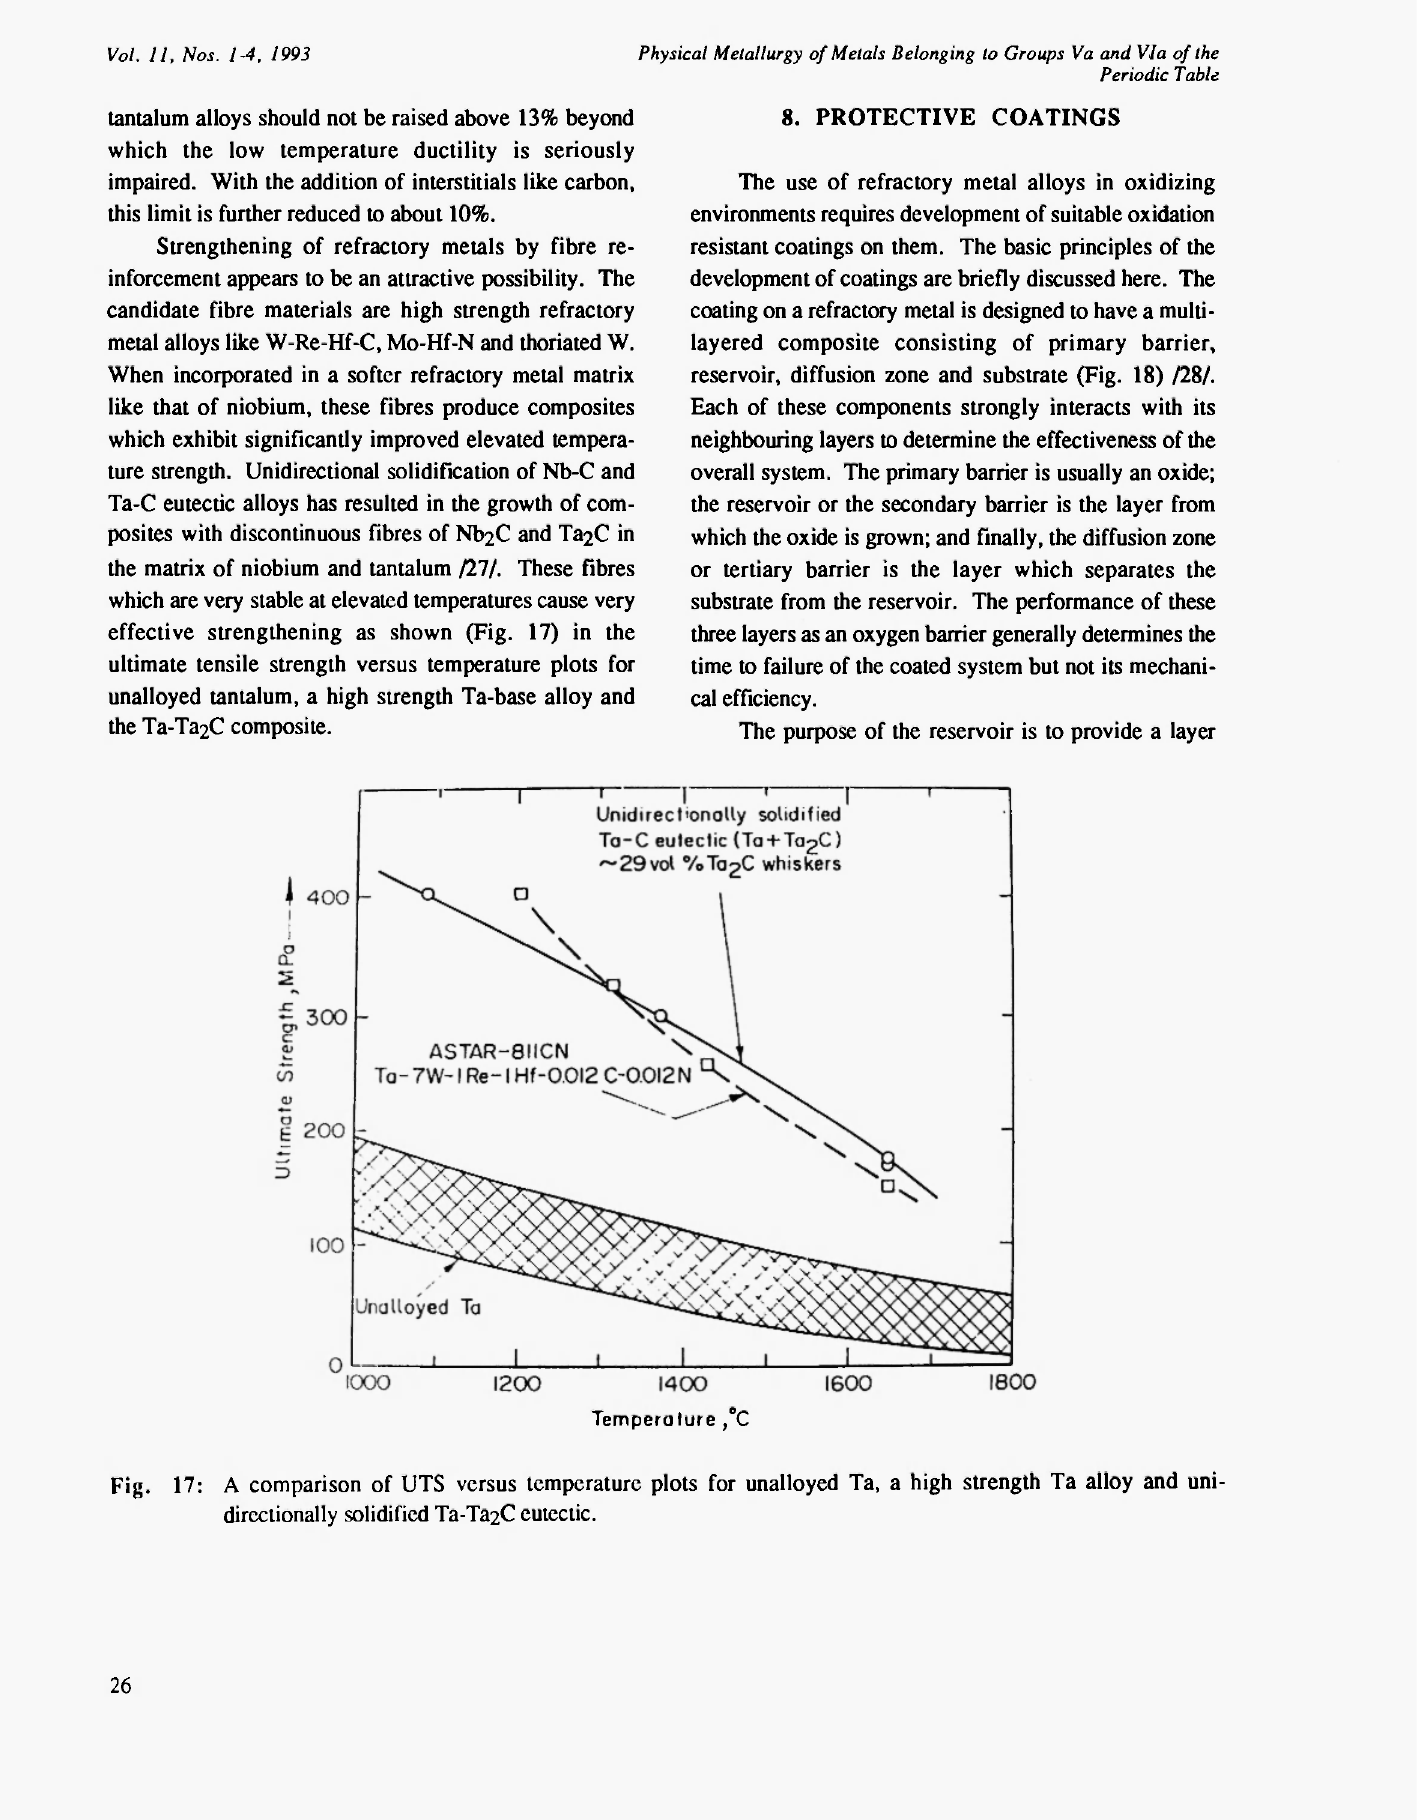
Fig. 17: A comparison of UTS versus temperature plots for unalloyed Ta, a high strength Ta alloy and uni- dircctionally solidified Ta-Ta2C